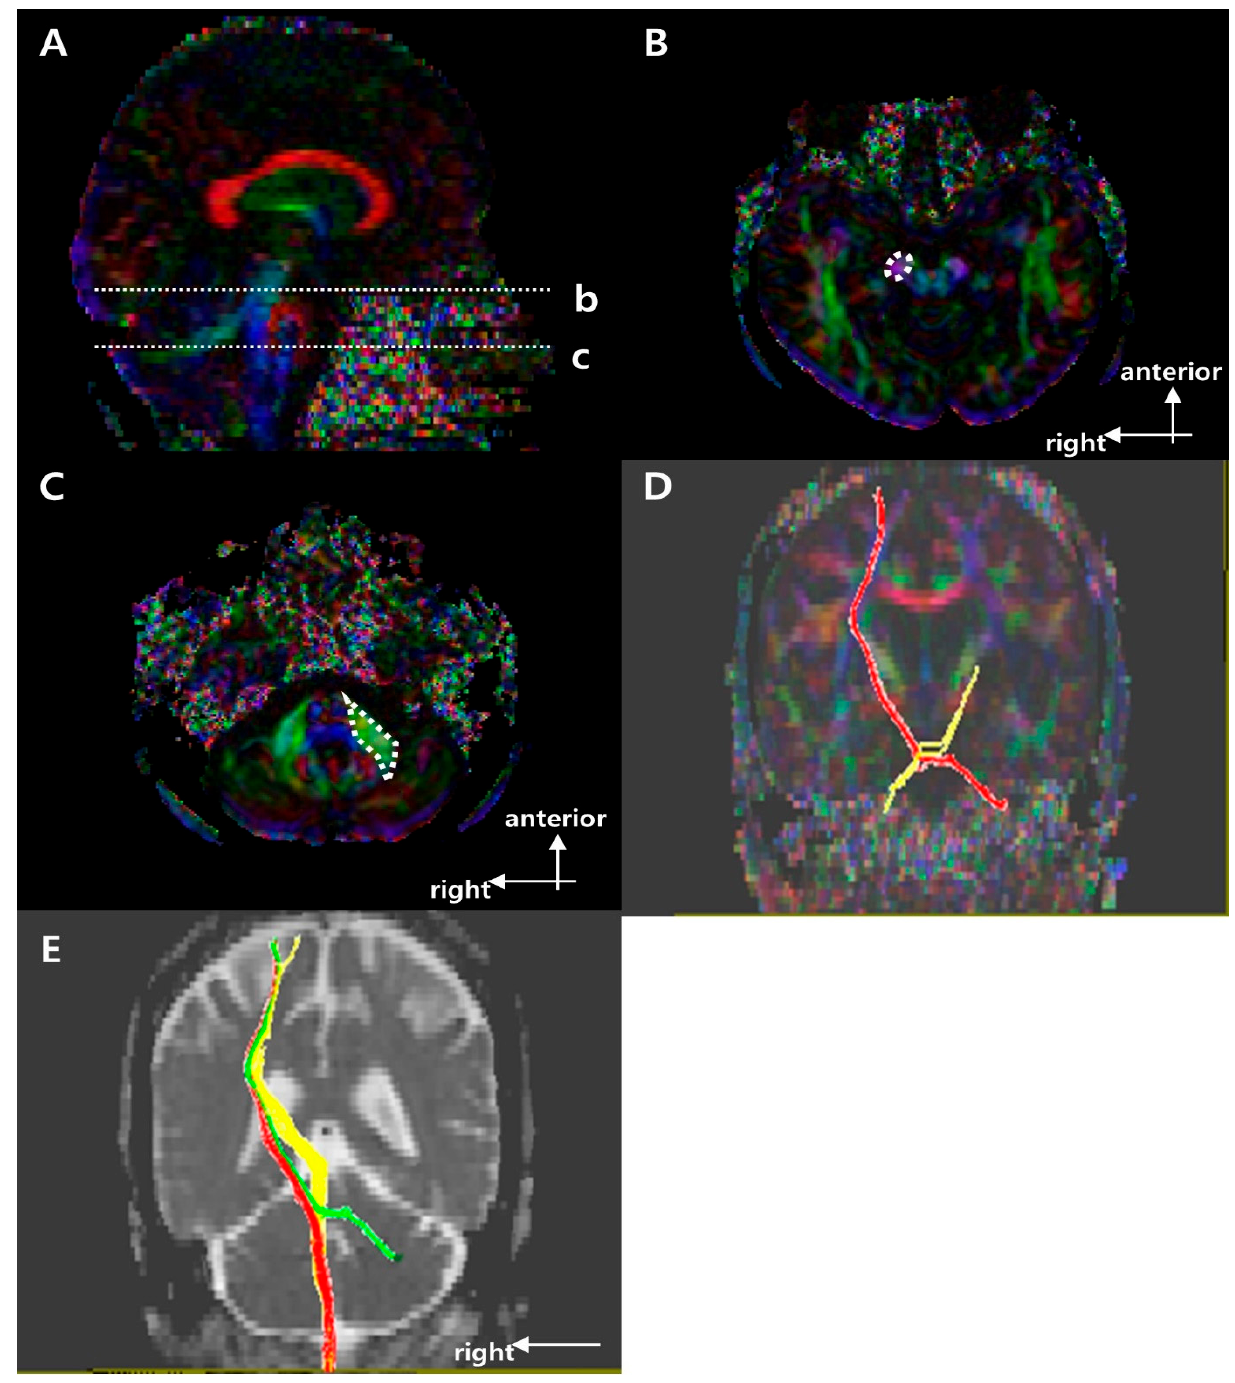
Figure 3. Regions of interest (ROIs) used to reconstruct the right cortico-ponto-cerebellar tract (CPCT) on diffusion tensor imaging (DTI) and representative diffusion tensor tractography (DTT) images of the CPCT. ( A ) Sagittal color fractional anisotropy (FA) map with the dotted lines showing the (b) cerebral peduncle and (c) mid pons. ( B ) The dotted circle indicates the target ROI of the CPCT at the cerebral peduncle in the axial color map (level b in ( A )). ( C ) The dotted polygon indicates the seed ROI of the CPCT at the middle cerebellar peduncle at the mid pons in the axial color map (level c in ( A )). ( D ) Representative DTT image of the CPCT in a typical subject with a left middle cerebral artery (MCA) infarction (red, unaffected side; yellow, affected side). ( E ) Representative superposing DTT image of the right side motor tracts in a typical subject with a left MCA infarction (red, CST; yellow, CRP; green, CPCT) in b = 0 image.